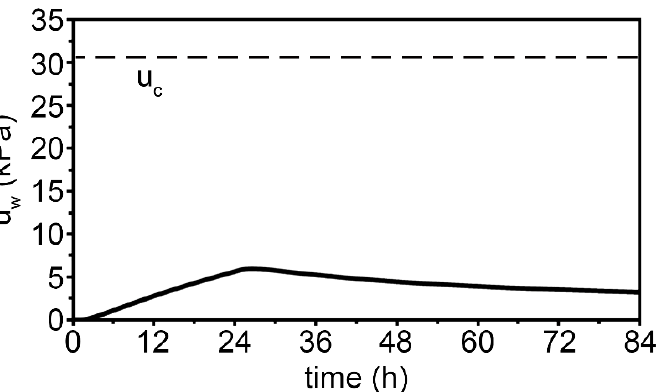
Figure 14. Evolution of the change in pore water pressure, u w , with time due to the rainfall of 10 April 2005, with indication of the critical threshold, u c , at the depth of 0.80 m.